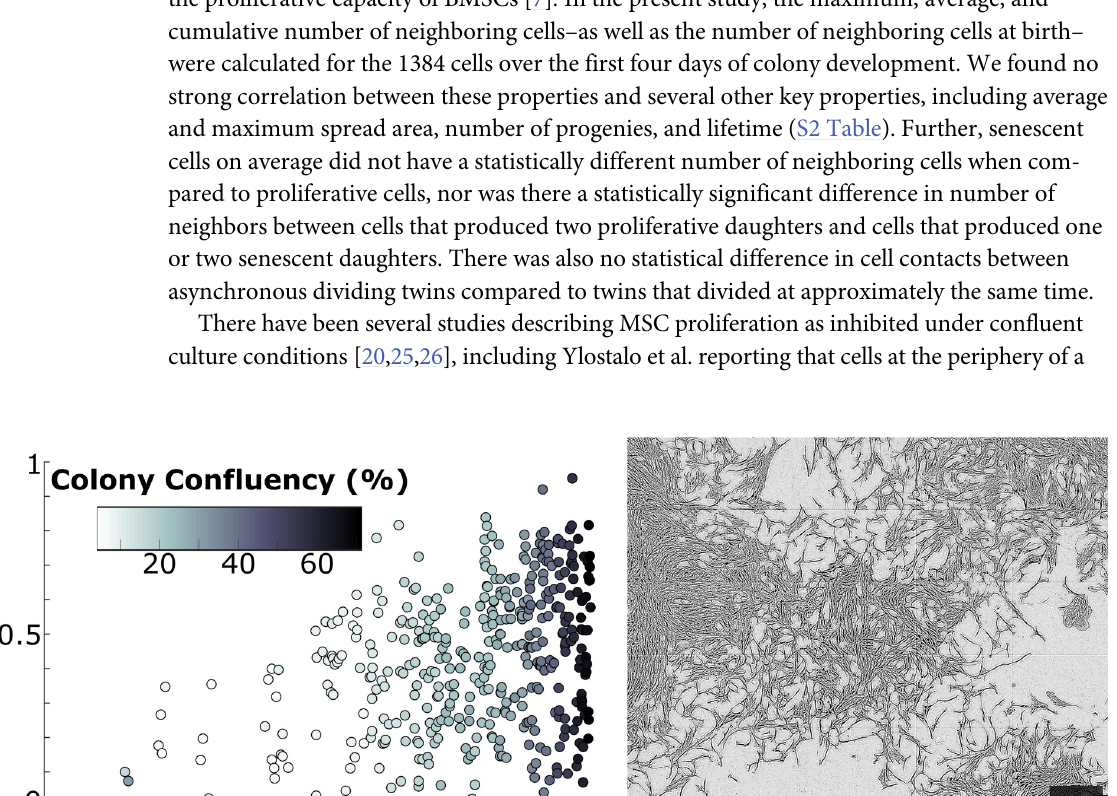
Fig 5. Most colonies contained senescent cells after four days of development, which is partially detectable by deviations in area dynamics. The spread area of cells was measured at every fifteen-minute time point for every colony during the first four days of development. Additionally, cells in each colony at Day 4 were monitored via time lapse videos and marked as senescent if they did not divide by Day 7. (A) The number of proliferative and senescent cells at Day 4 is reported. The color of the colony label represents the number of originating progenies, and colonies are rank-ordered by the fraction of cells that were senescent. (B) The Spearman correlation coefficient r p value for the comparison of average cell area versus generation is presented for all progenies contributing to colony formation. The majority of progenies exhibited a negative trend between area and generation to varying degrees of statistical significance. The dashed horizontal line indicates the Bonferroni-corrected p value threshold for a significant correlation, and the color of the progeny data points represents the number of originating cells their respective colony developed from. (C) Cells belonging to all colonies also showed a negative trend between area and generation when their datasets were pooled, where the area of each cell was calculated as the average area of all time points during the first 0.83 days of their lifetimes. The Spearman correlation coefficient and associated p value is also reported (N = 1384). (D) Line plots of individual cell area in single progenies over time are presented for three progenies. Data lines are color-coded by cell generation, with the exception of senescent cells (labeled black). Many progenies uniformly produced smaller cells with each new generation (left); however, heterogeneity onset occurred when cells deviated from this trend, occasionally due to senescence (middle) or from cells having longer lifetimes (right). Also displayed for each progeny is the Spearman correlation coefficient and associated p- value for the comparison of average cell area versus generation, as presented in (B).